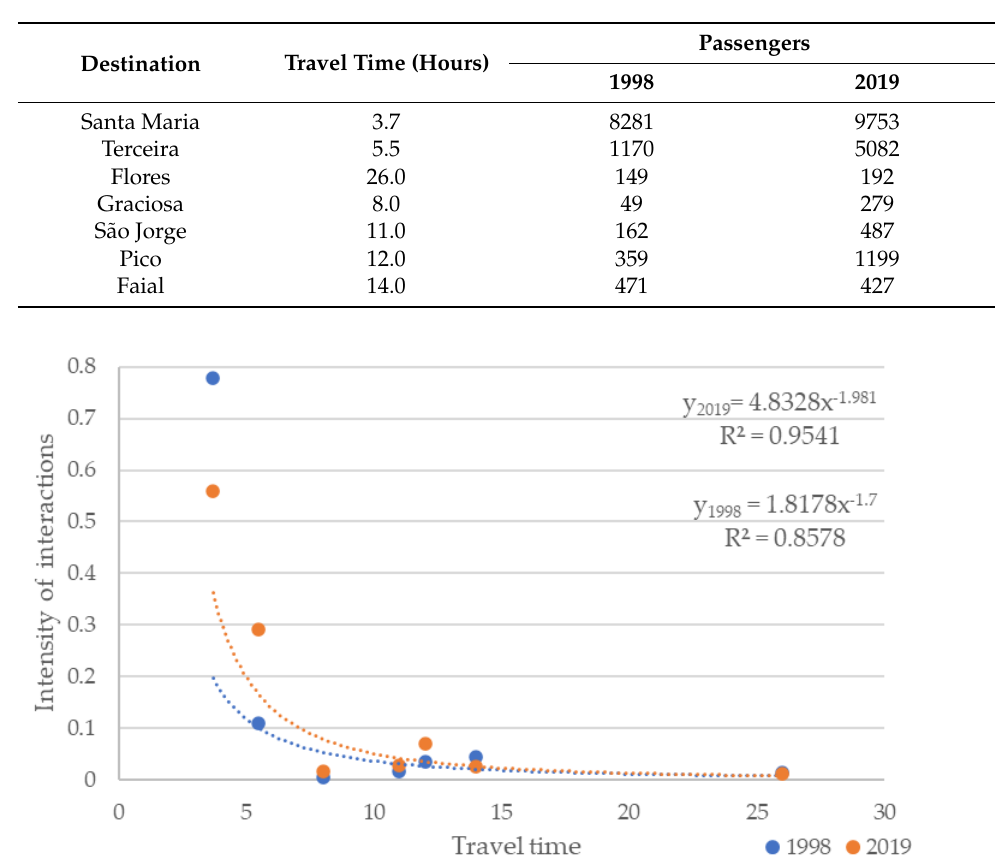
Table 8. Data for maritime connections to Santa Maria Island from the rest of the archipelago — for 1998 and 2019.